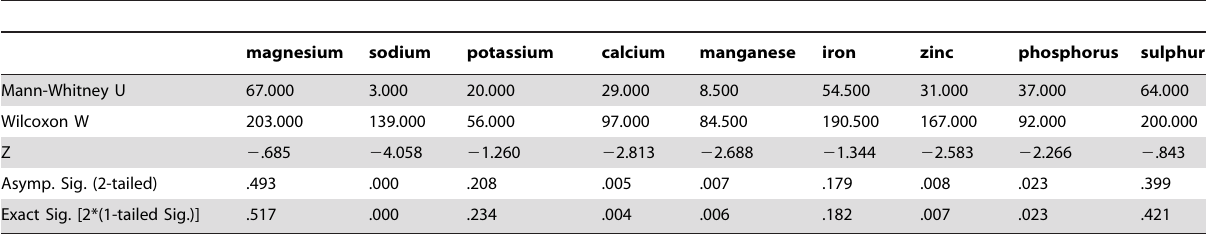
Table 2. Mann-Whitney U-test results: raphia samples (without wadge sample) vs all other